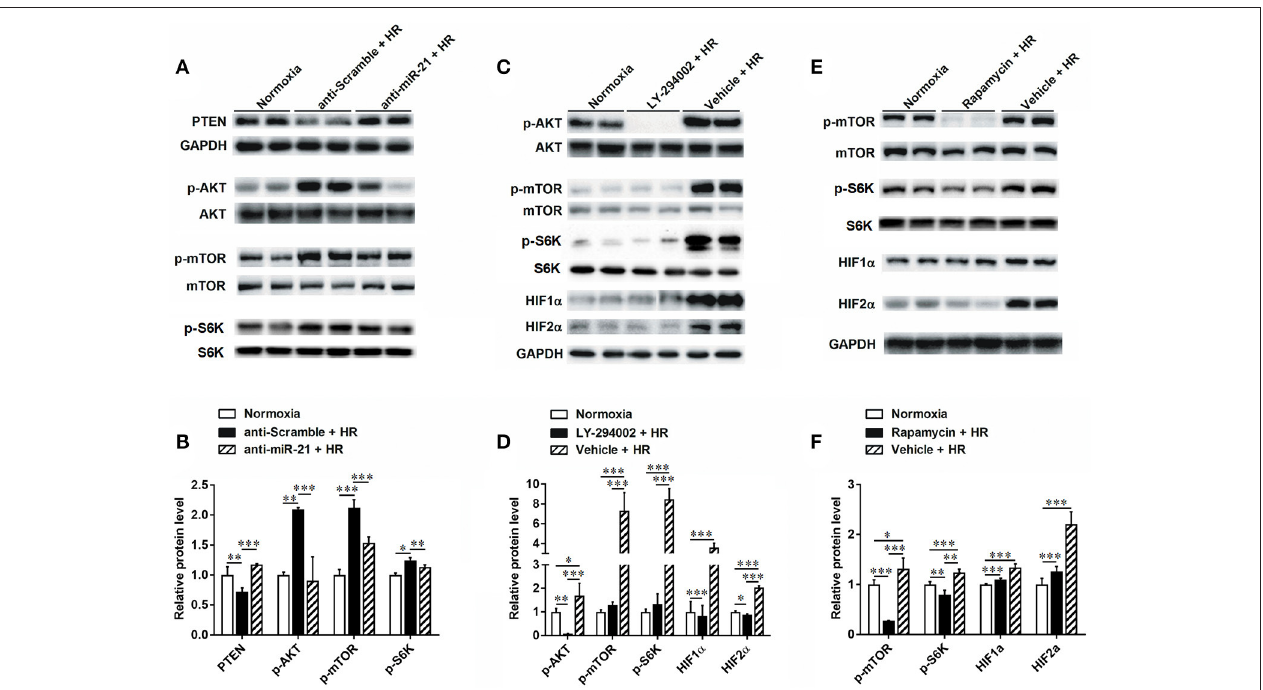
FIGURE 6 | HR inducible miR-21 mediated HIF-1 α and HIF-2 α expression through PTEN/AKT/mTOR pathway. (A) HK-2 cells were transfected with LNA-modified anti-miR-21 or the scrambled control under hypoxia/reoxygenation and normoxic conditions. Western blotting was performed to analyze the expression of PTEN and phosphorylation of AKT and mTOR. HR treatment inhibited expression of PTEN, otherwise increased phosphorylation of both AKT and Mtor. (B) Group data from (A) . (C) Phosphorylation of AKT was blocked by treating HK-2 cells with 50 µ M LY294002 during HR. Inhibition of AKT prevents phosphorylation of mTOR and inductions of HIF-1 α and HIF-2 α under HR condition. (D) Group data from (C) . (E) Phosphorylation of mTOR was blocked by treating HK-2 cells with 10nM rapamycin during HR. Inhibition of mTOR reduced HIF-1 α and HIF-2 α stabilization. (F) Group data from (E) . * p < 0.05, ** p < 0.01, *** p < 0.01, n = 6.